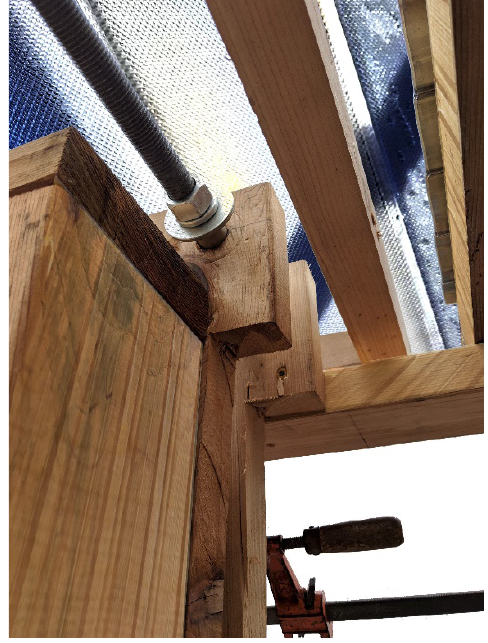
Figure 12. The Butterfly Roof and Hinge, 2018.